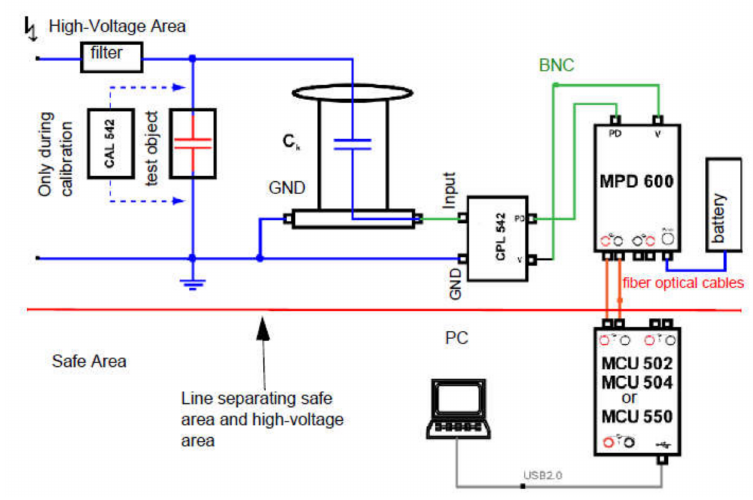
Figure 8. Omicron MPD600 and connection